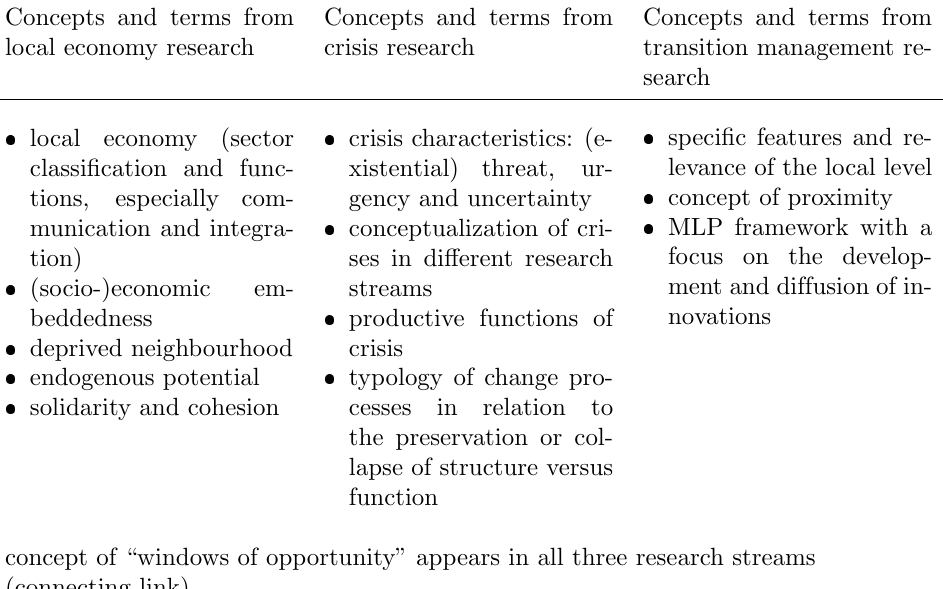
Table 1: Concepts and terms relevant to the case study, own representation Concepts and terms from Concepts and terms from local economy research crisis research (cid:136) local economy (sector classification and func- tions, especially com- munication and integra-